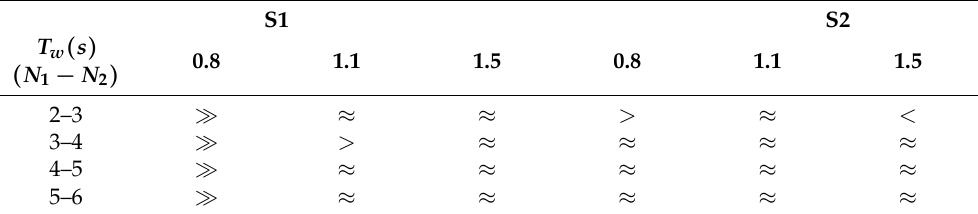
Figure 4. The accuracy of the turbo detector when it has adopted the S1 and S2 training data selection strategies with 0.8–1.5 s data length. The error bars represent the standard error. Table 1. Paired t -test of turbo detector with different values of N .